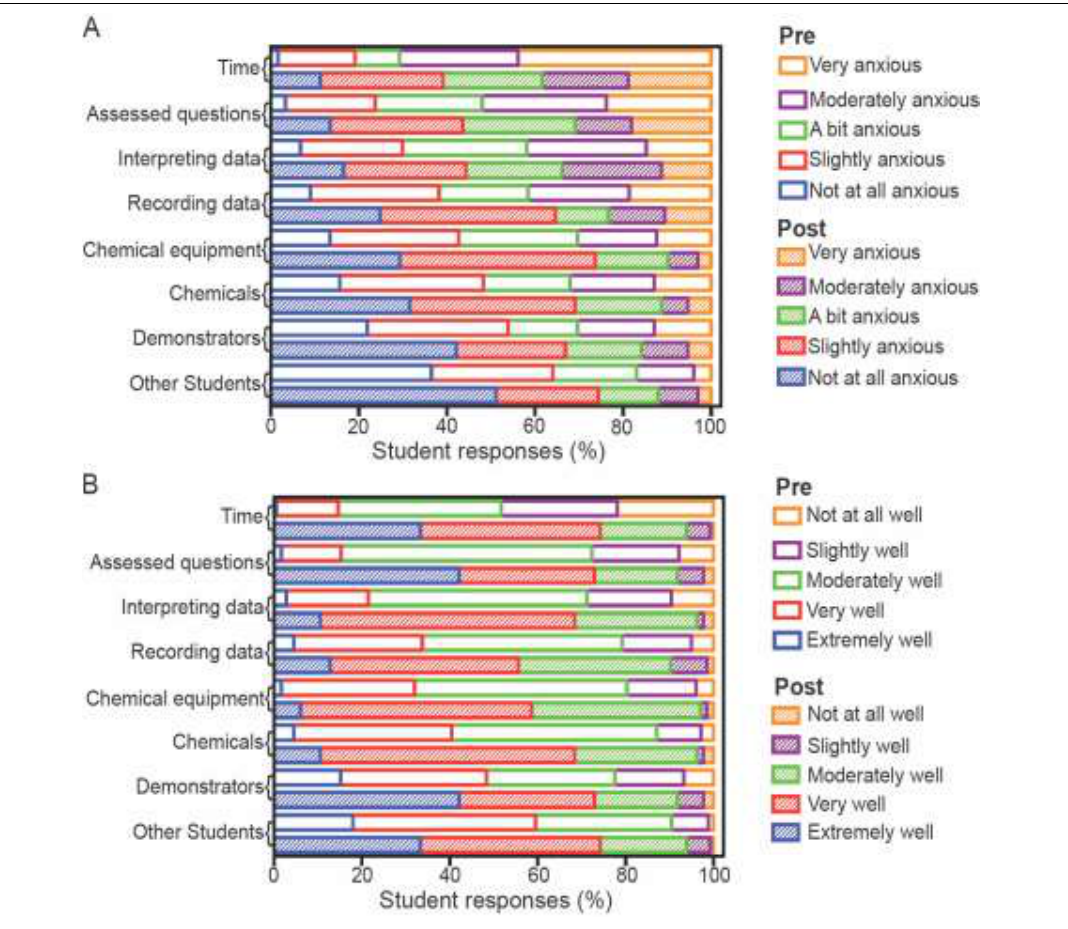
Figure 1. Student responses to perceived levels of A) anxiety and B) self-efficacy towards different aspects of the laboratory at the beginning (pre) and end (post) of the semester. N=178 student responses pre and N=133 student responses